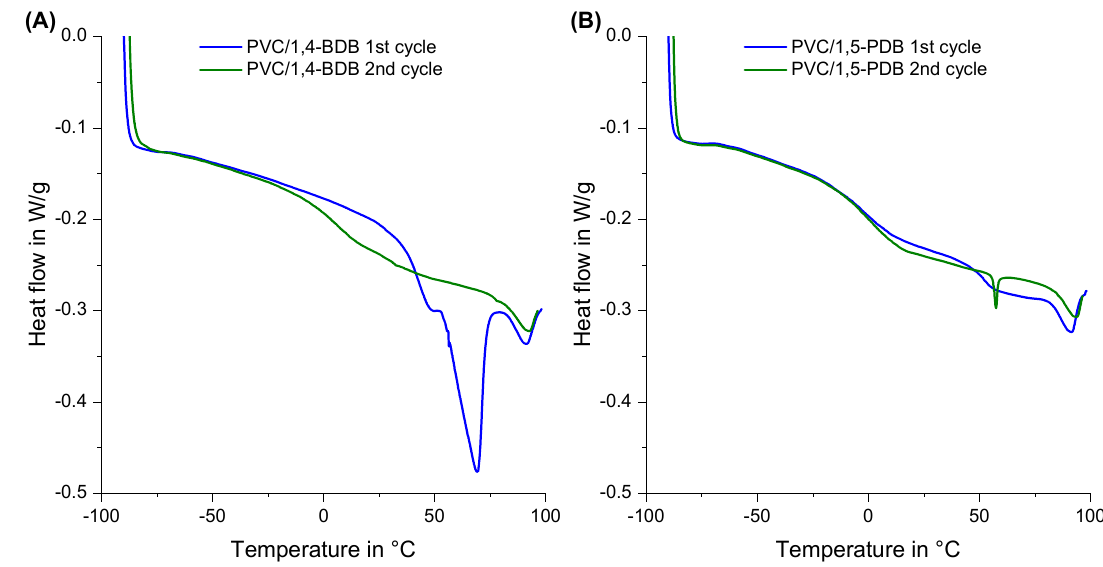
Figure 3. DSC curves for the first (blue) and second (green) heating cycles of a 40 phr blend of ( A ) PVC/1,4-BDB and ( B ) PVC/1,5-HDDB.